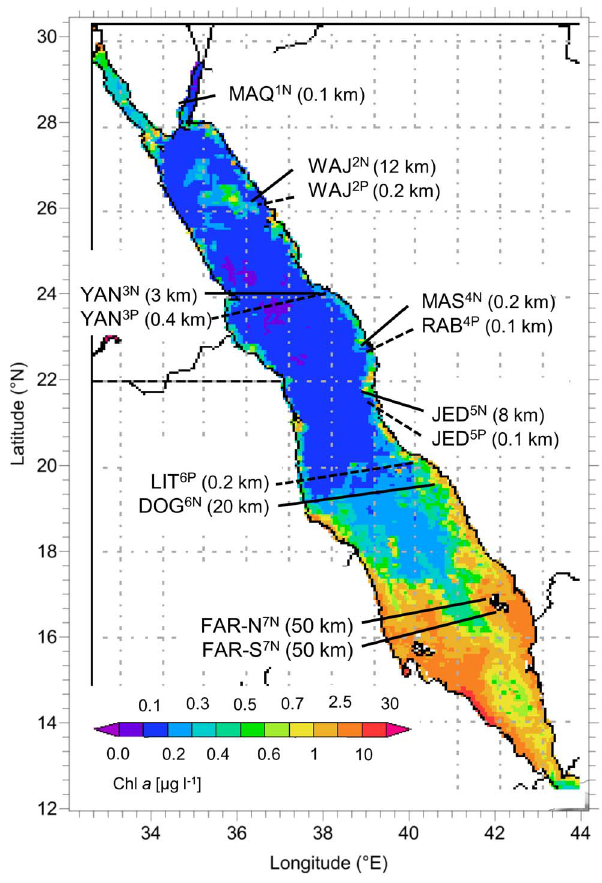
Fig. 1. Map of the Red Sea showing (A) the sampling sites from N to S Maq 5 Maqna, Waj 5 Al Wajh, Yan 5 Yanbu, Mas 5 Masturah, Rab 5 Rabigh, Jed 5 Jeddah, Lit 5 Al Lith, Dog 5 Doga, and Far 5 Farasan Islands (coordinates can be found in Table 1) with the mean annual chlorophyll a (Chl a ) concentrations from April 2011 to March 2012 at the surface. Chlorophyll a data are derived from satellite images of NASA, Giovanni online data system, Ocean Color Radiometry, data set: MODIS-Aqua 4 km.The superscripts behind the 3-letter site abbreviation designate the site sequence from north to south (digits) and the pollution status with ‘‘N’’ 5 non-polluted and ‘‘P’’ 5 polluted. The km values indicate the reefs distance from shore.